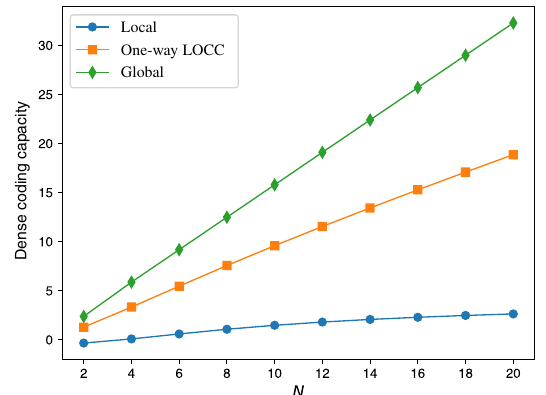
FIG. 6. Three dense coding capacities— C E ((cid:2) ) with one-way LOCC decoders, local encoders, C E AF g , D → ((cid:2) ) with global decoders—as functions of N , and C E AF g , D glb where N is the number of identical parties. We set parameter p = 1 /